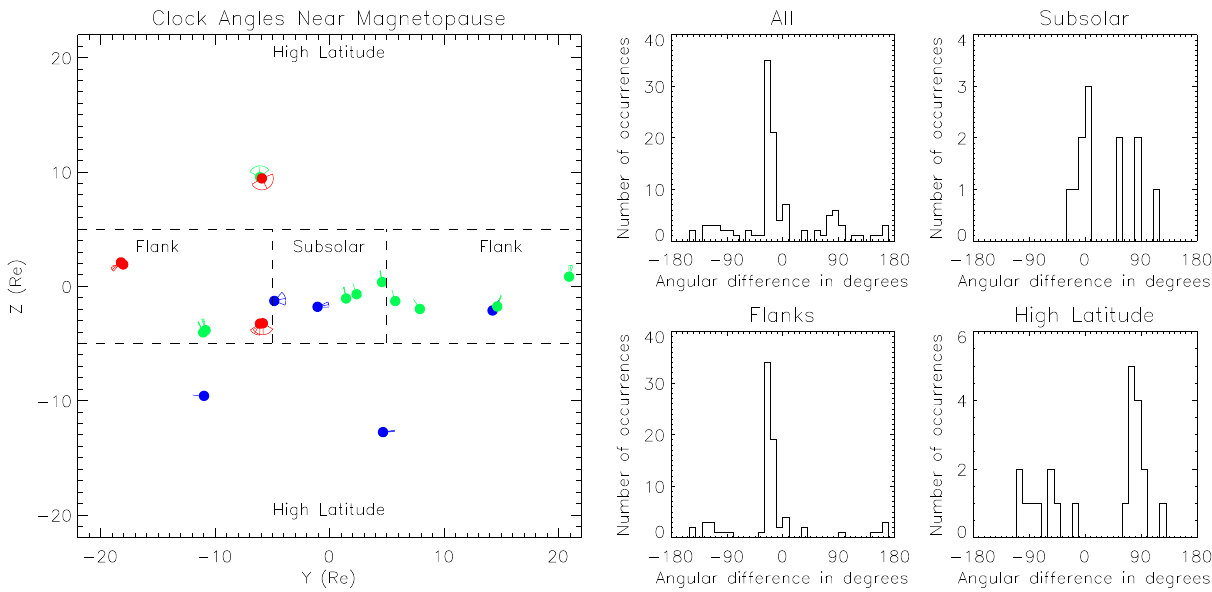
Fig. 13. Clock angles measured near magnetopause, and angular differences from perfect draping, for high solar wind dynamic pressure and Northward IMF. Format as Fig. 2.